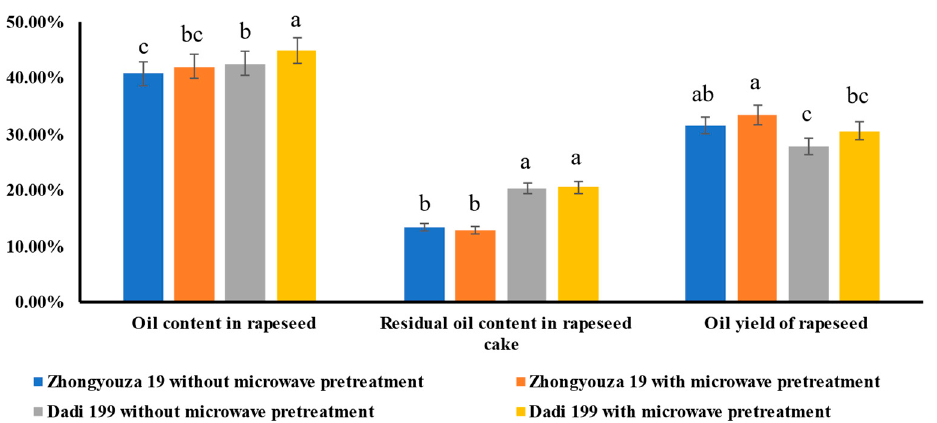
Figure 8. Analysis of the oil content in rapeseed, the residual oil content in rapeseed cake and the oil yield in oil processing with/without microwave pretreatment of rapeseed. Values are the means ± standard deviations; n = 3 parallel determinations. a–c Mean values (a > b > c, corresponding to the same parameter) not followed by a common letter differ significantly ( p < 0.05).